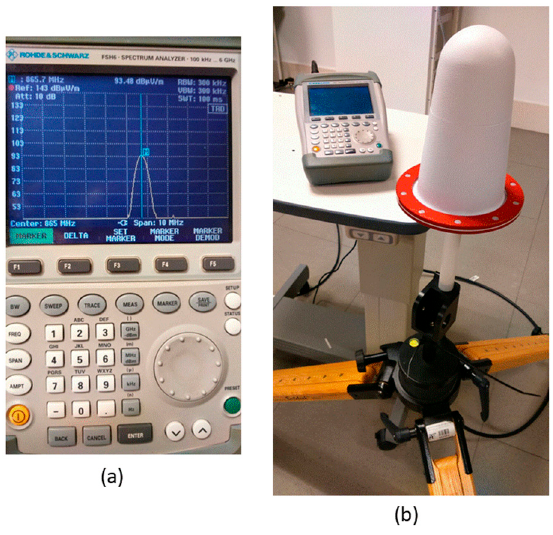
Figure 3. Measurement set up used for in situ measurements of EMF emitted by studied RFID readers: ( a ) Rhode & Schwartz FSH6 spectrum analyzer, ( b ) Antenna ETS-LINDGREN, Mod.3181 on tripod.